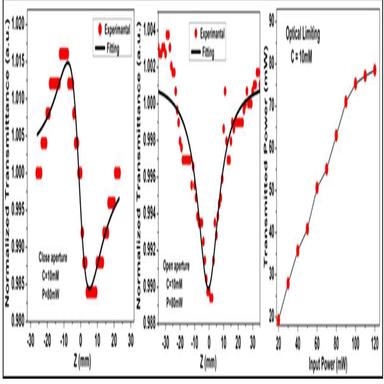
(a) Close aperture normalized transmittance (b) open aperture normalized transmittance, and (c) The optical limiting behavior.